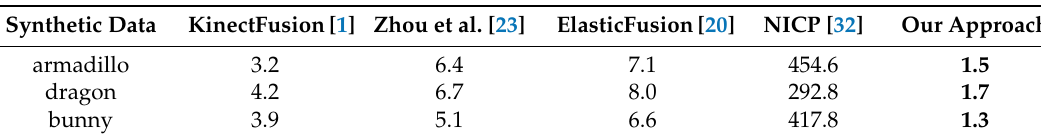
Table 2. Evaluation of the odometry accuracy with absolute trajectory error (ATE) RMSE metric in millimeters.